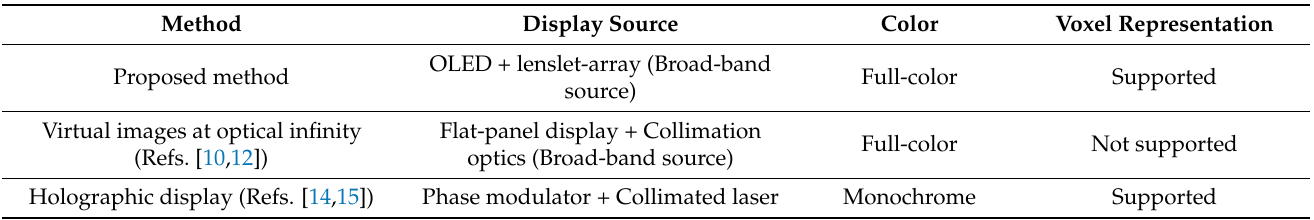
Table 3. Comparison among the proposed method and previous research for the NEDs based on holographic waveguide.